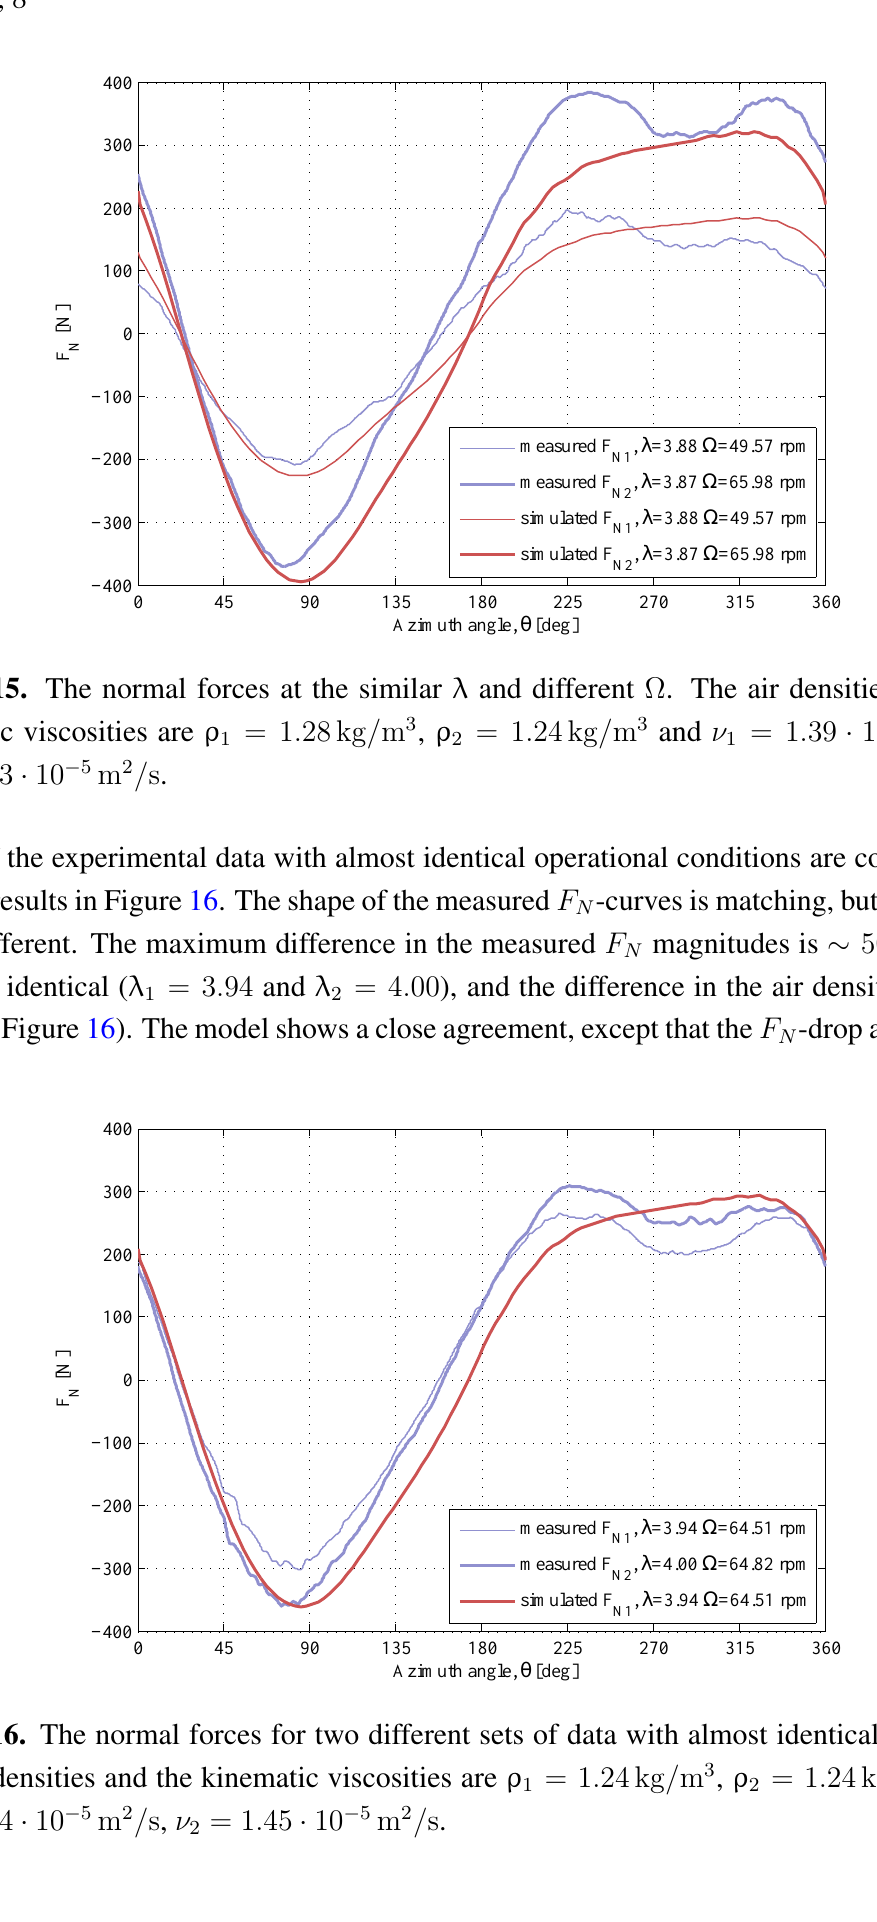
= 1 . 45 · 10 − 5 m 2 / s 2